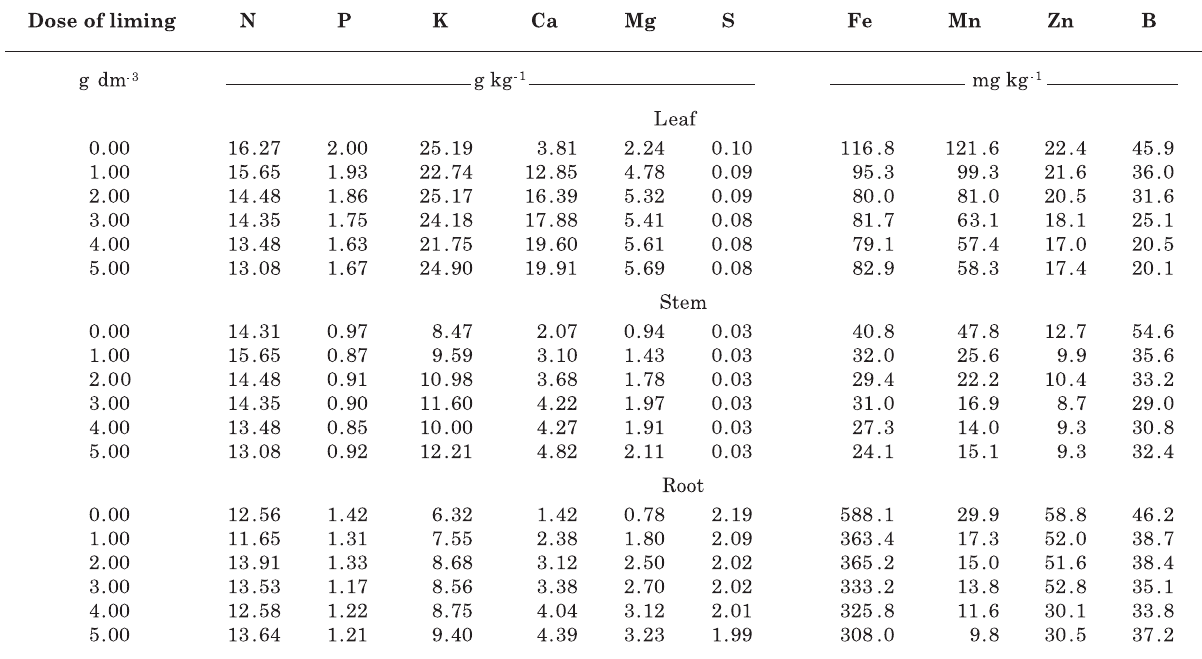
Table 1. Concentrations of macro and micronutrients in leaves, stems and roots of Epidendrum ibaguense in response to lime rates applied to the growth